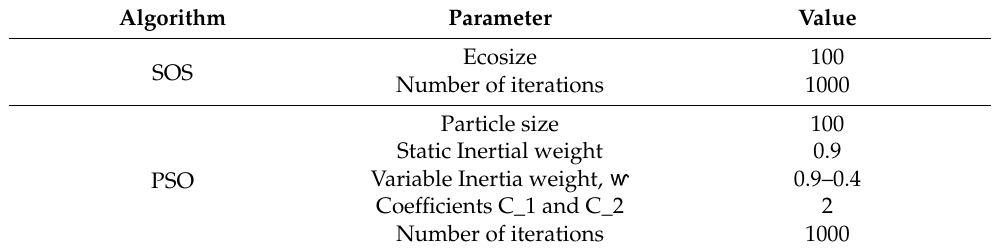
Table 2. Parameter settings for SOS and PSO.